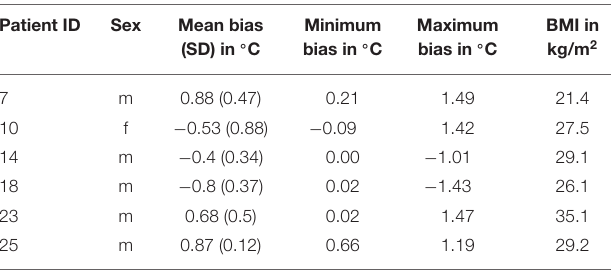
TABLE 4 | Patients with a noticeable difference in the bias between temperatures measured between esophageal temperatures and the double sensor. Patient